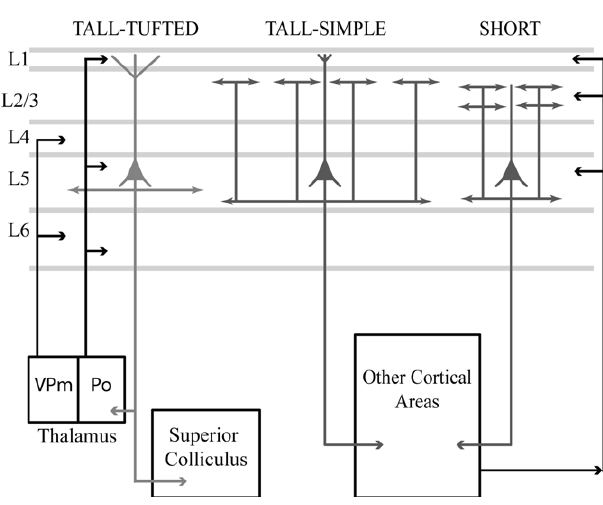
Figure 6. Schematic summarizes results and differences in morpholo- gies, inputs, and projection targets between the three cell types in layer 5. The tall-tufted layer 5 pyramidal neurons project subcortically to both the thalamic nucleus Po and the superior colliculus, and only maintain local axonal arbors within the deep layers. This cell type receives extensive input within layer 1, potentially from the thalamic nucleus Po, corticocortical projec- tions, and local inhibitory neurons. The tall-simple layer 5 pyramidal neurons project to other cortical areas and maintain local axons in both the superfi cial and deep layers. In addition, the axonal arborization within layer 2/3 appears to be patchy and extends farther in the horizontal direction. This cell type also receives input from layer 1, but signifi cantly less than the tall-tufted layer 5 pyramidal neurons. The short layer 5 pyramidal neurons also project to other cortical areas and maintain local axons in both the superfi cial and deep lay- ers in cortex, but unlike the tall-simple neurons’ their superfi cial projection is more columnar in appearance. The short layer 5 pyramidal neurons are unable to receive input from layer 1 and most likely are integrating input from other cortical